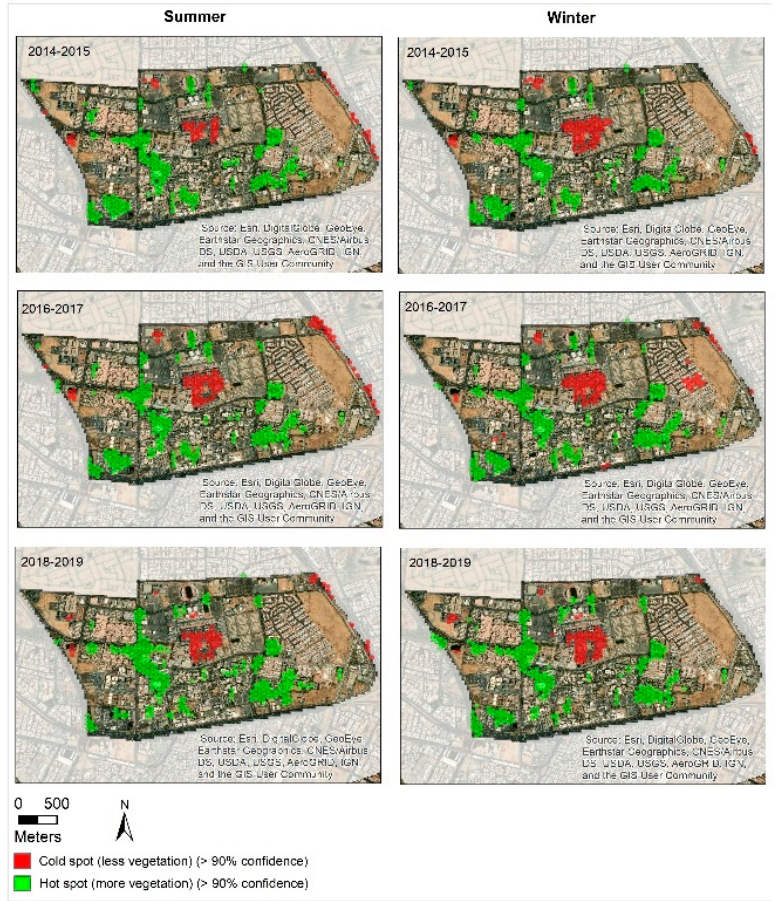
Figure 6. Hot spots and cold spots of live vegetation (measured according to NDVI) in the summer and winter of 2014–2015, 2016–2017, and 2018–2019.